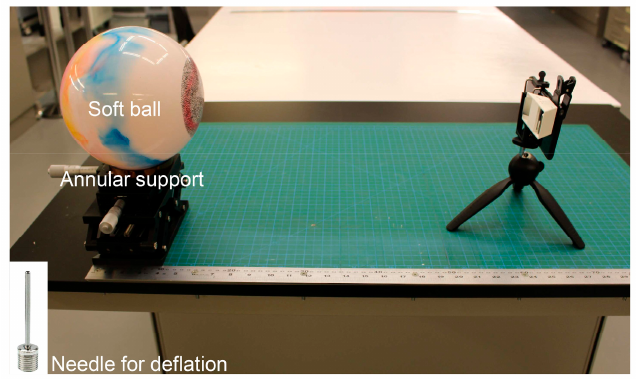
Figure 13. Experimental set-up for the 3D deformation measurement of a deflating ball. The insert image is the needle for deflation during the test.